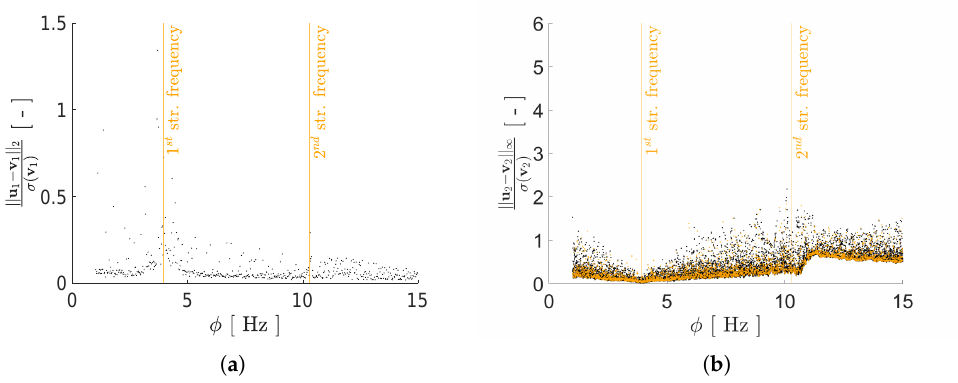
Figure 12. Two-storey shear building, configuration A, P = 4. Reconstruction errors as a function of the load frequency φ : ( a ) standardized L 2 norm relevant to the floor displacement v 1 for the test set; ( b ) standardized L ∞ norm relevant to the floor displacement v 2 for the training (black dots) and validation (orange dots)